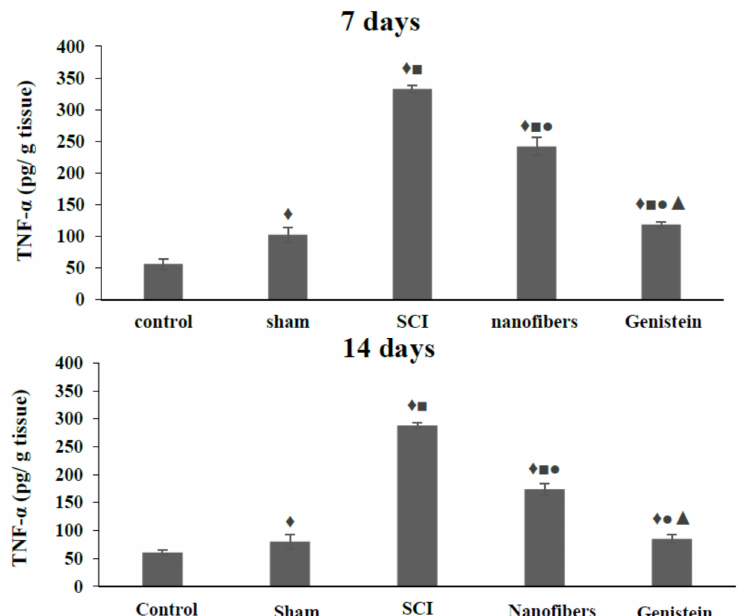
Figure 5. Levels of tumor necrosis factor-alpha (TNF- α ) (pg/g tissue) in spinal cord tissue. The TNF- α levels in spinal cord tissue of SCI group exhibited a significant ( (cid:7) , (cid:4) p < 0.05) increase with respect to control and sham groups at all the time intervals. Treatment with nanofibers only or genistein nanofibers caused a significant ( , p < 0.05) decrease in the levels of TNF- α in spinal cord tissue at all time points compared to SCI group. Levels of TNF- α in spinal cord tissue decreased significantly ( (cid:78) , p < 0.05) in genistein group when compared with nanofibers group at the same time points. Number of animals ( n = 5). (Mean ±